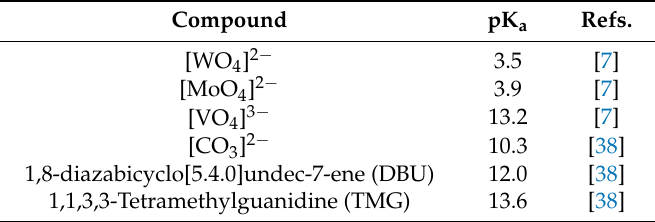
Figure 2. Ball and stick representations of the anion parts of POM base catalysts and natural bond orbital (NBO) charges of oxygen atoms [38,55,56]. orbital (NBO) charges of oxygen atoms [38,55,56]. Table 1. pK a values of the conjugate acids of various inorganic and organic bases.